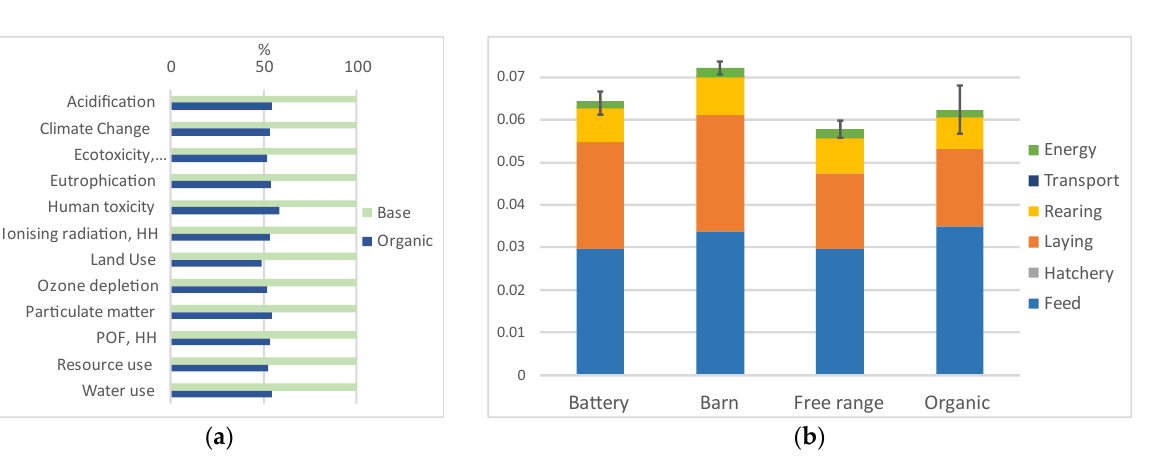
Figure 7. Changes in impact categories for organic eggs with the same yield as eggs produced in a battery system using Environmental Footprint 3.0, for one kilogram of eggs: ( a ) compared to the baseline; ( b ) normalized and weighted total results compared to battery, barn, and free-range eggs.